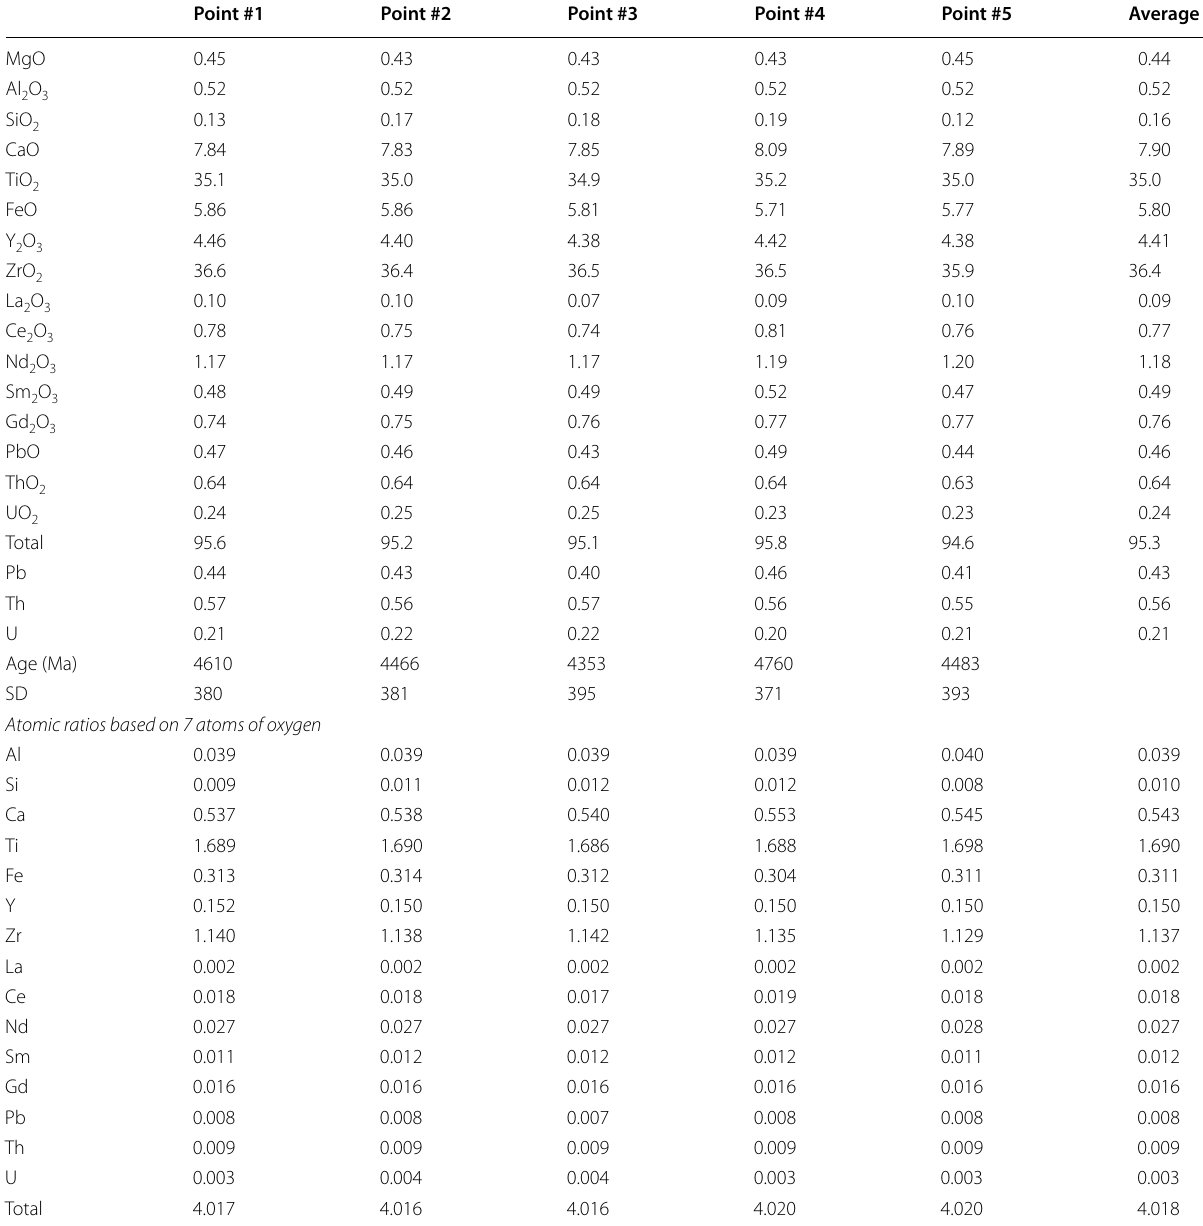
Table 1 EPMA analyses of the zirconolite grain from NWA 4485, in